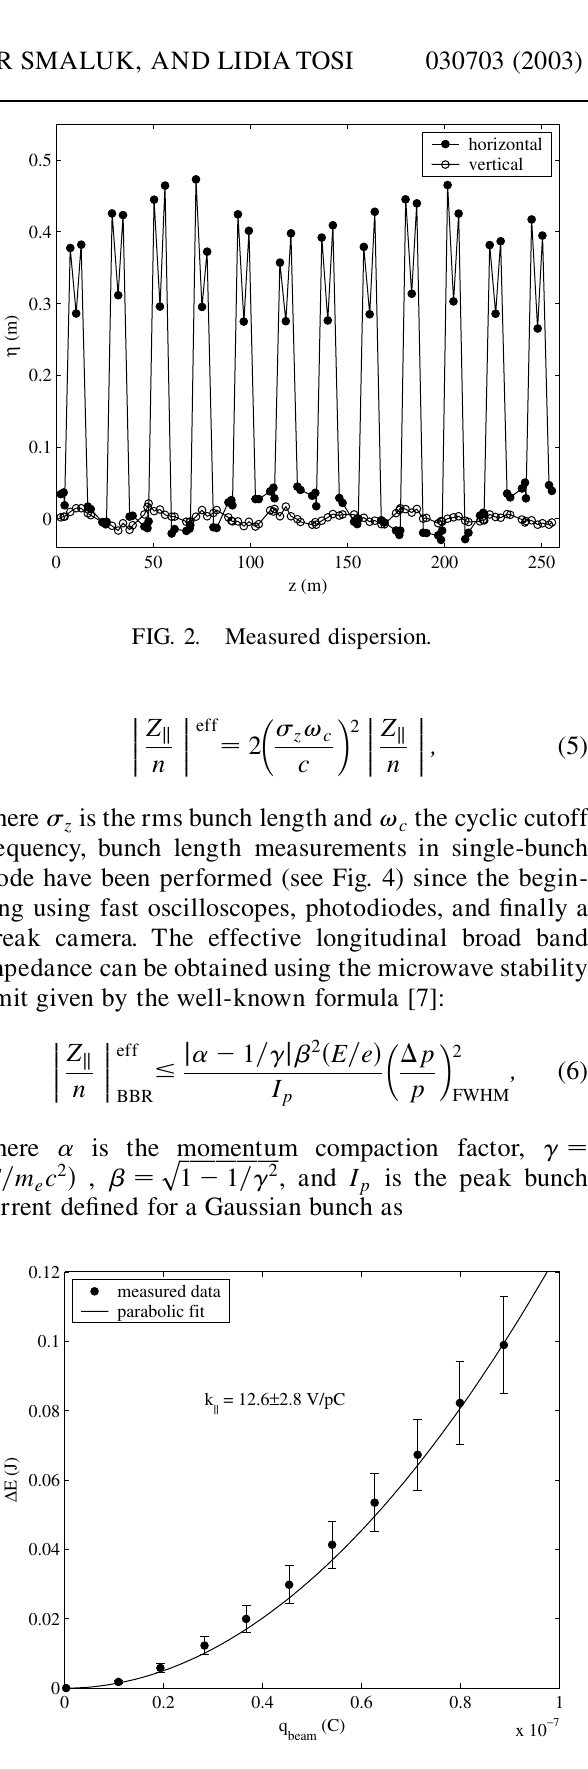
FIG. 3. Total longitudinal energy loss versus beam charge.